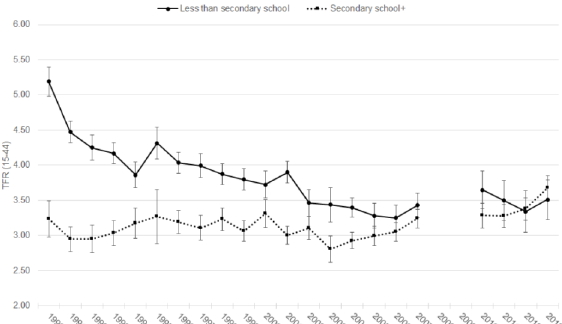
Fig 3. Annual TFRs by level of education,